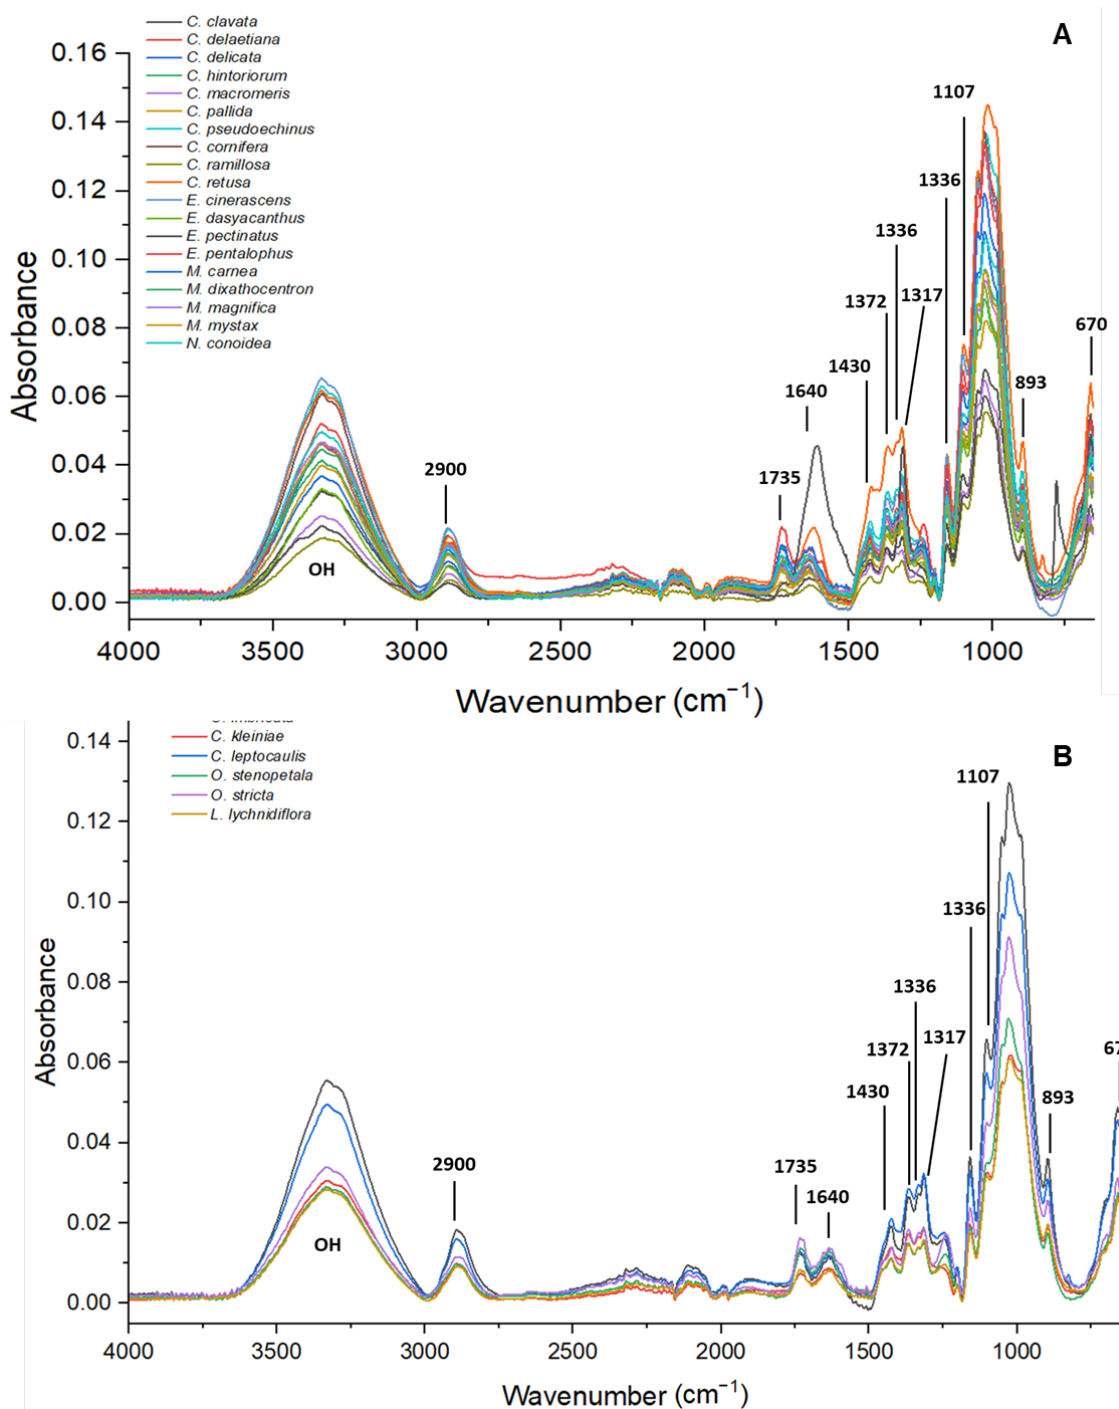
Figure 1. FTIR spectra for obtaining cellulose crystalline indexes for the 25 Cactaceae species. ( A ) Non-fibrous species. ( B ) Fibrous species. Table 2. Assignment of FTIR absorption bands for the cellulose of Cactaceae species.